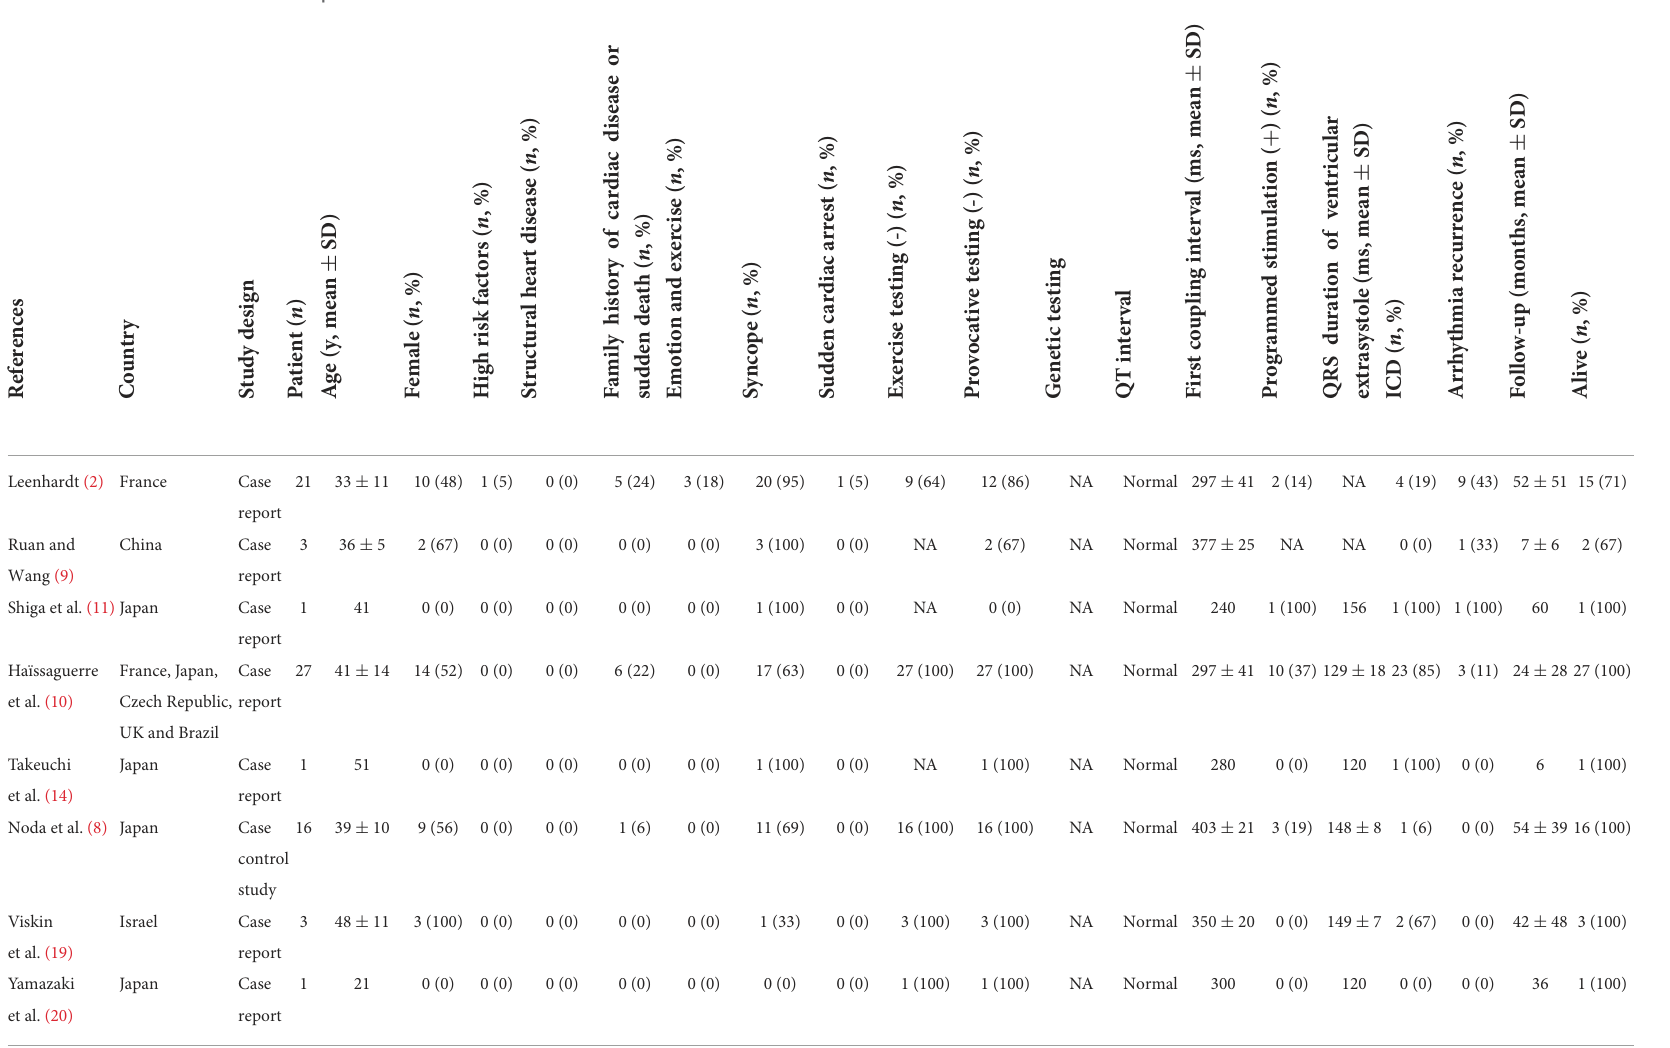
TABLE 1 Characteristics of the case